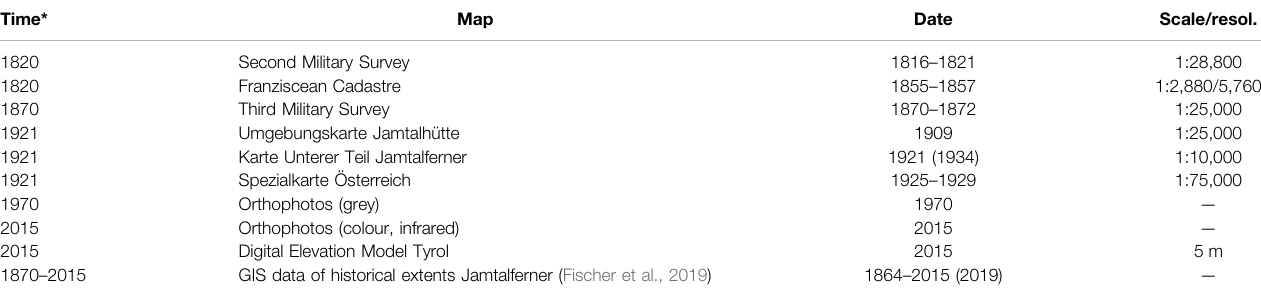
TABLE 2 | Main historical sources and contemporary datasets used for the reconstruction of the historical land cover in the Jamtal (*reconstructed time step; dates in brackets: year of publication). Time*